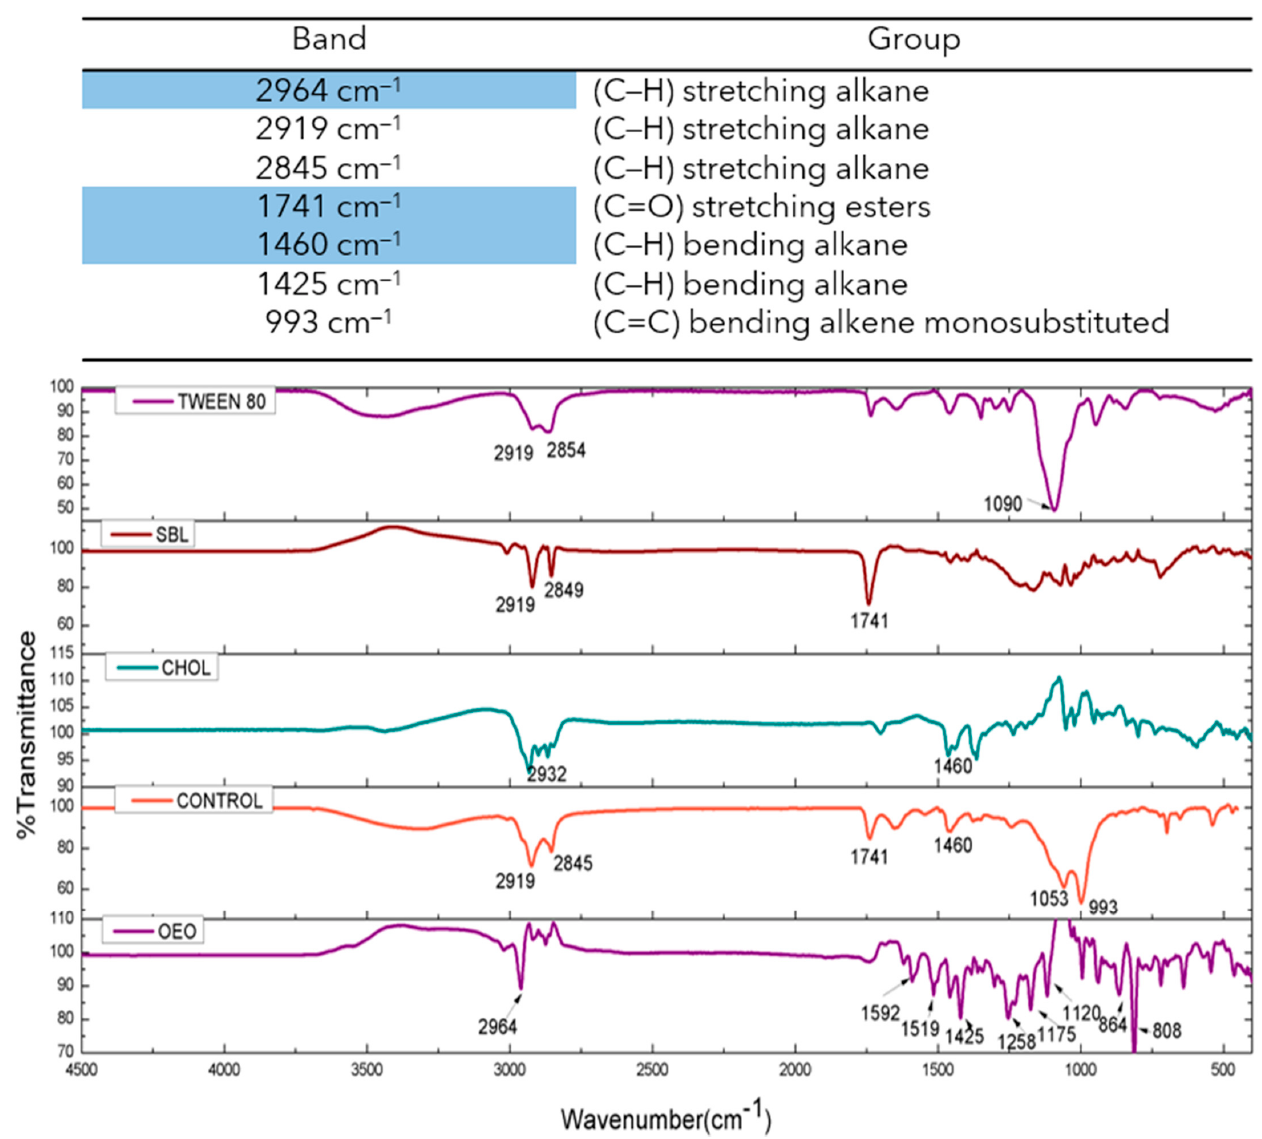
Figure 5. Infrared spectra of the main ingredients of nanoliposomes (SBL, Chol, Tween-80 ® , OEO and the empty nanoliposome referred to as the control).